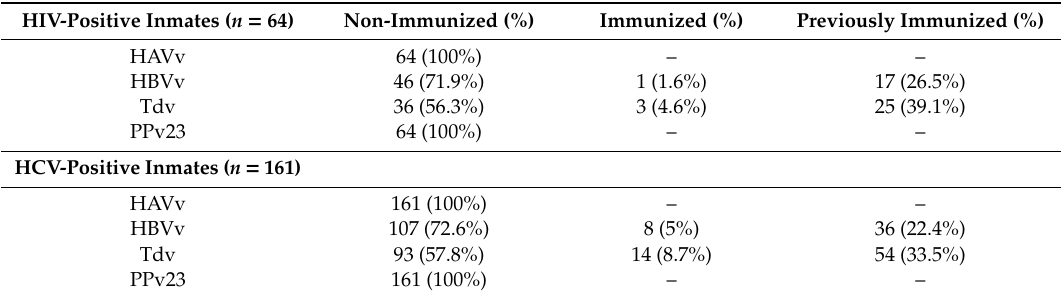
Table 6. Immunization coverage of HIV-positive and HCV-positive inmates. HIV-Positive Inmates ( n = 64)